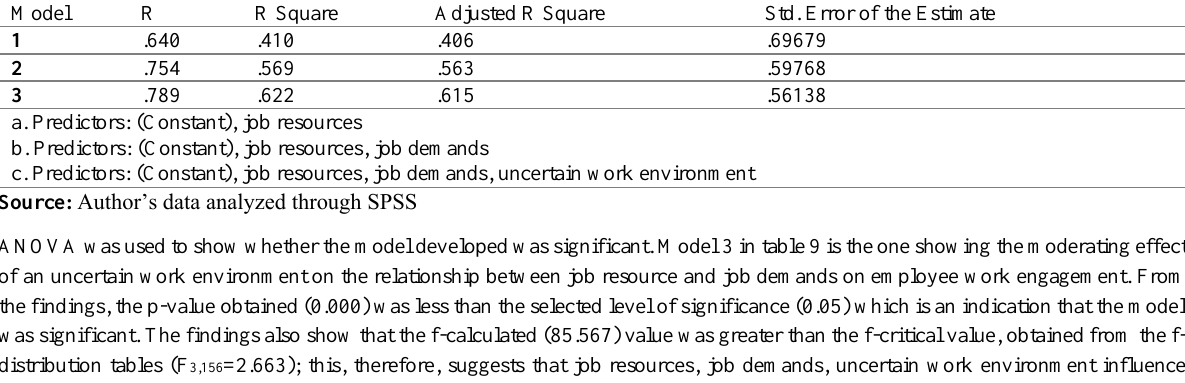
Table 8: Model summary for the moderating effect of uncertain work environment Model